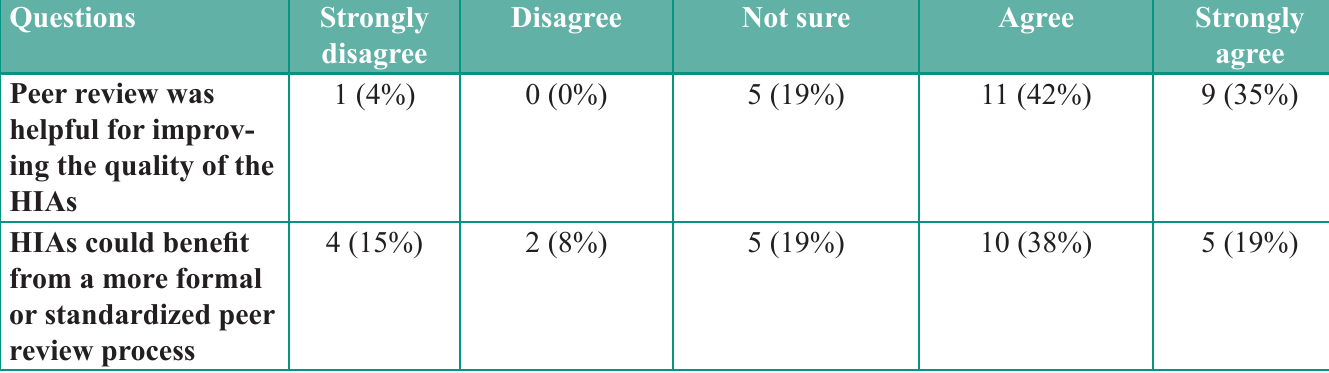
Table 3: Number of respondents (and %) who agreed or disagreed with statements. (n=26)